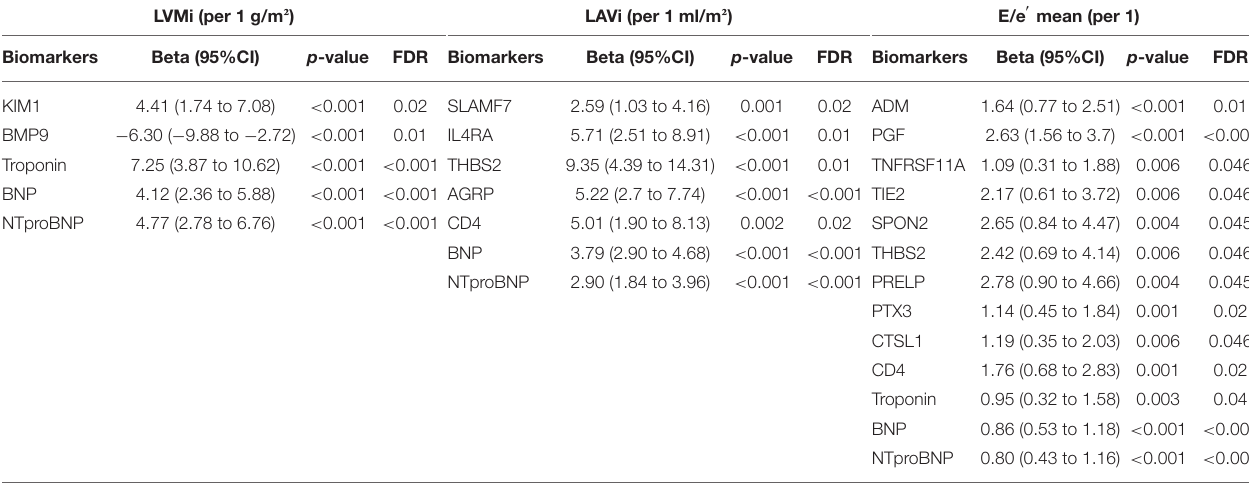
TABLE 2 | Multivariable selected biomarkers for each echocardiographic parameter in the RA porto cohort. LVMi (per 1 g/m ² ) LAVi (per 1 ml/m ² ) E/e ′ mean (per 1)